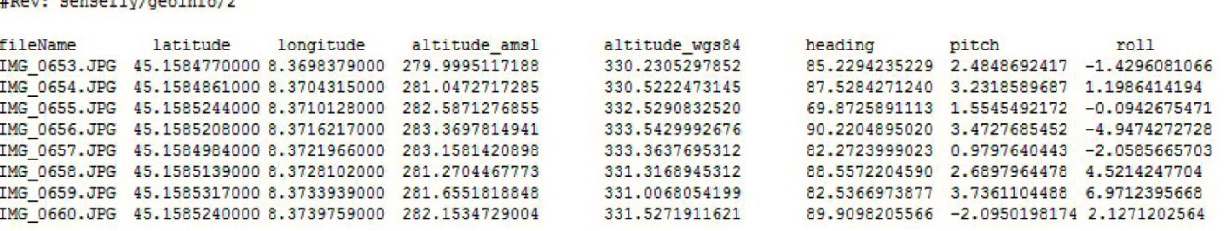
Figure 10. Example of the external orientation parameters as measured by the eBee platform, required for the direct georeferencing